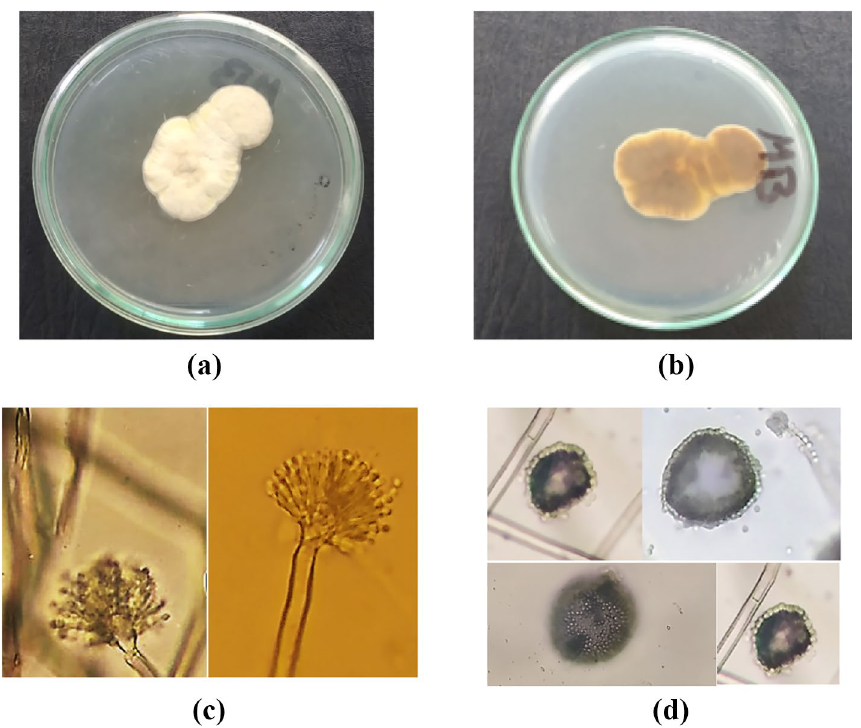
Figure 2. Aspergillus flavipes MN956655. ( a ); colony on Czapek’s Dox medium, ( b ); reverse of plate, ( c ); conidial head, ( d ); Hülle